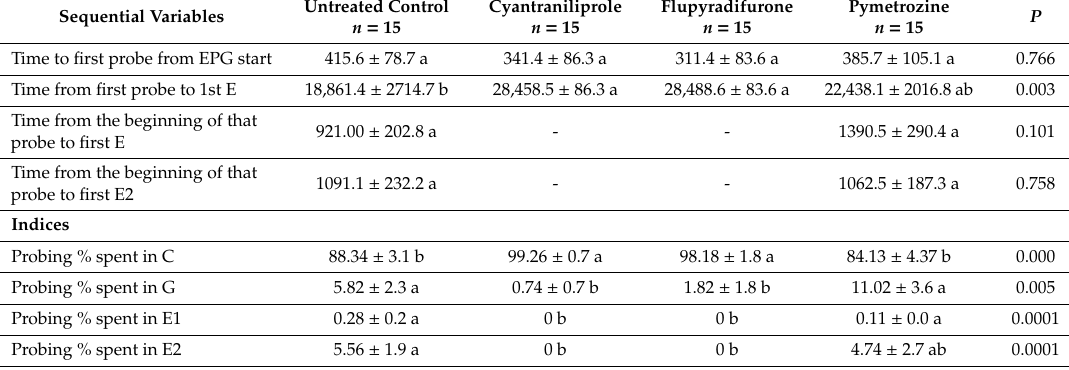
Figure 2. Nonsequential EPG variables (mean ± SE) for whiteflies exposed to tomato plants treated with systemic insecticides (cyantraniliprole, flupyradifurone, and pymetrozine) and untreated plants. ( A and B ) Number of waveform events per insect (NWEI); ( C and D ) Waveform duration per insect (WDI; time expressed in seconds). Waveform nonprobe, no stylet contacts with leaf tissue; Probe, all activities into plant tissue in which stylets were involved (Waveforms C, pds, F, G, E1, and E2); Waveform E1, salivation in sieve element; Waveform E2, passive phloem sap uptake from sieve elements. Mean values followed by different letters were significantly different ( P ≤ 0.05) according to Dunn’s test with Bonferroni correction. Table 1. EPG variables of probing and feeding behavior of Bemisia tabaci exposed to insecticide-treated and untreated plants. Values represent mean ± standard error of sequential variables and percentage of probing time spent in a specific waveform (time expressed in seconds).